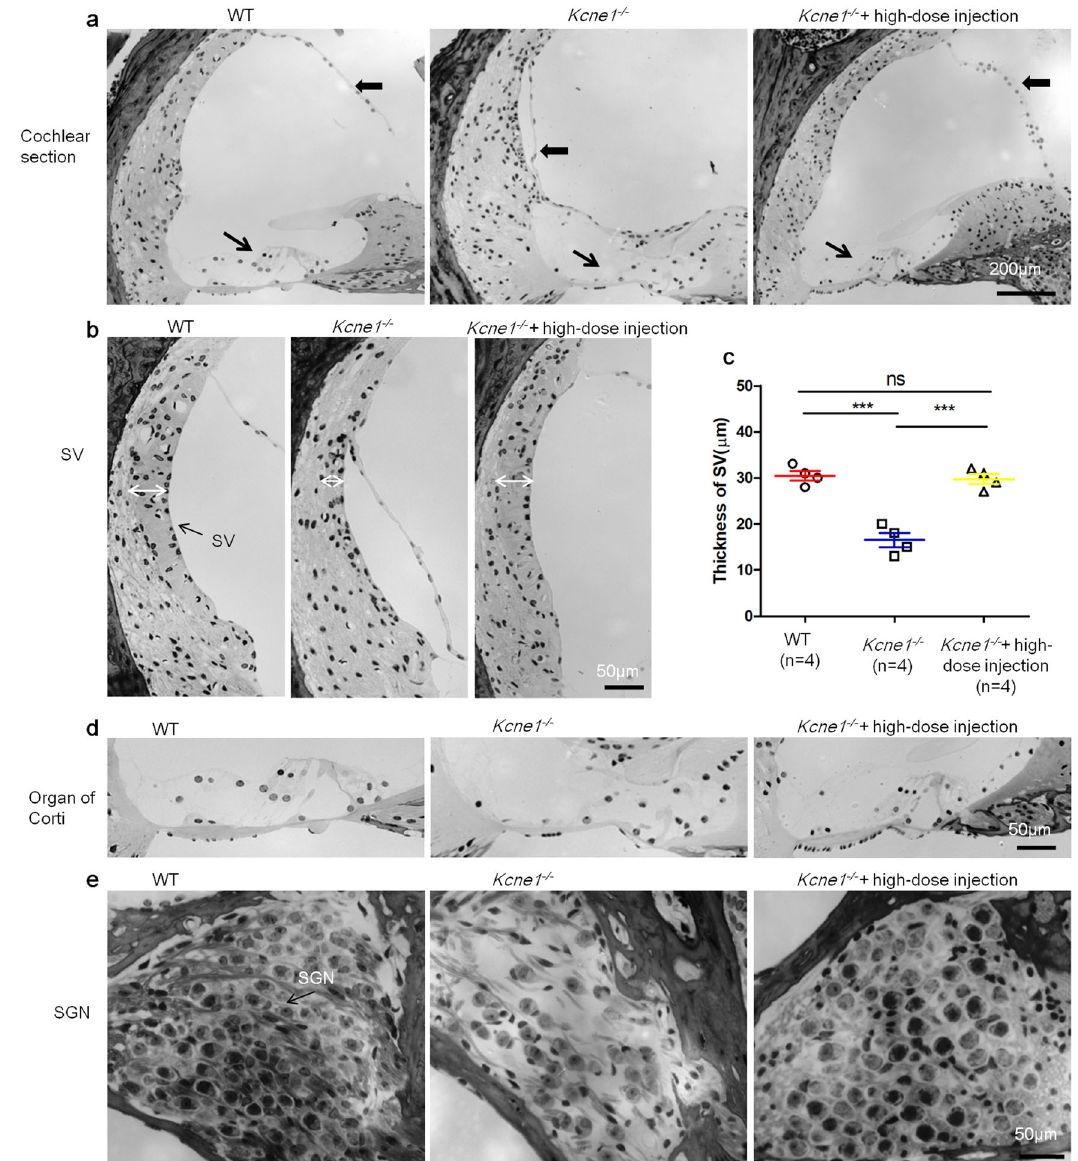
Fig. 5 Morphologies of cochlear sections in the middle turn of WT, untreated, and high-dose-treated Kcne1 − / − mice observed at P30 ( n = 4 in each group). a Comparison of the morphology of the cochlear section of WT, untreated, and high-dose-treated Kcne1 − / − mice. b Comparison of the thickness of the stria vascularis (SV) in the middle turn of the WT, untreated, and high-dose-treated Kcne1 − / − mice. c Quantitative comparison of the thicknesses of the SV in the WT, untreated, and high-dose treated Kcne1 − / − mice ( n = 4 in each group, p = 0.0003 in WT ears and p = 0.0004 in treated Kcne1 − / − ears, comparing to untreated Kcne1 − / − ears, two-sided Student ’ s t tests). Data are shown as mean ±SEM. ***: p < 0.001. Source data are provided as a Source data fi le. d Comparison of the morphology of the organ of Corti of the WT, untreated, and high-dose-treated Kcne1 − / − mice. e Comparison of the morphology of spiral ganglion neurons (SGNs) in the middle turn of the WT, untreated, and high-dose-treated Kcne1 − / − mice. Heavy black arrows point to the Reissner ’ s membrane. Fine black arrows point to the organ of Corti. White double-headed arrows indicate the border for measuring the thickness of the